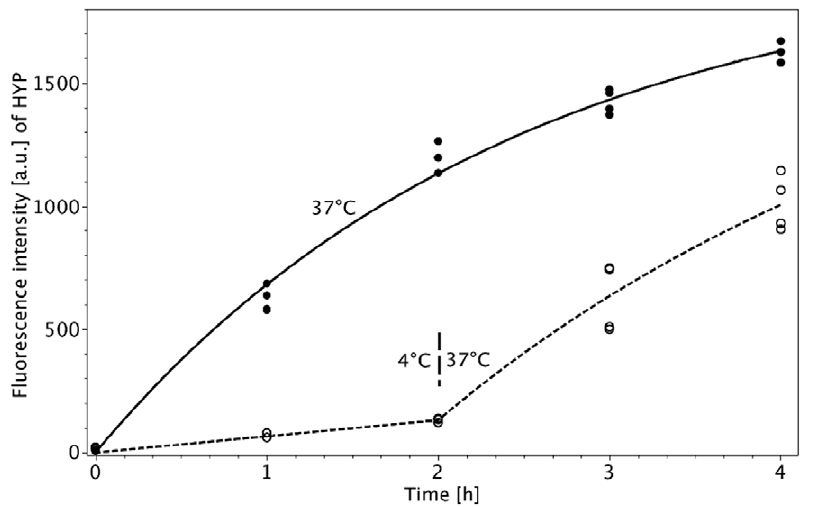
N Figure 5. Cellular accumulation of HYP in D283 Med medulloblastoma cells (concentration 2.5 m M) versus temperature [4 6 C for 2 h )], as measured by flow cytometry. The observations are fitted according to and subsequently 37 6 C for further 2 h (O) vs. 37 6 C for 4 h ( the Formula (3a) (continuous line for constant 37 u C incubation) and Formula (3b) (dashed line for temperature switch at 2 hours). The initial slopes are given in Table 2. ( R 2 ~ 98 : 8% ; we calculated absolute errors.).